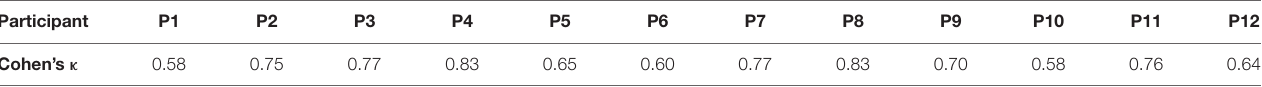
TABLE 3 | Statistical reliability for individual participants (standard error ± 0.02). Participant